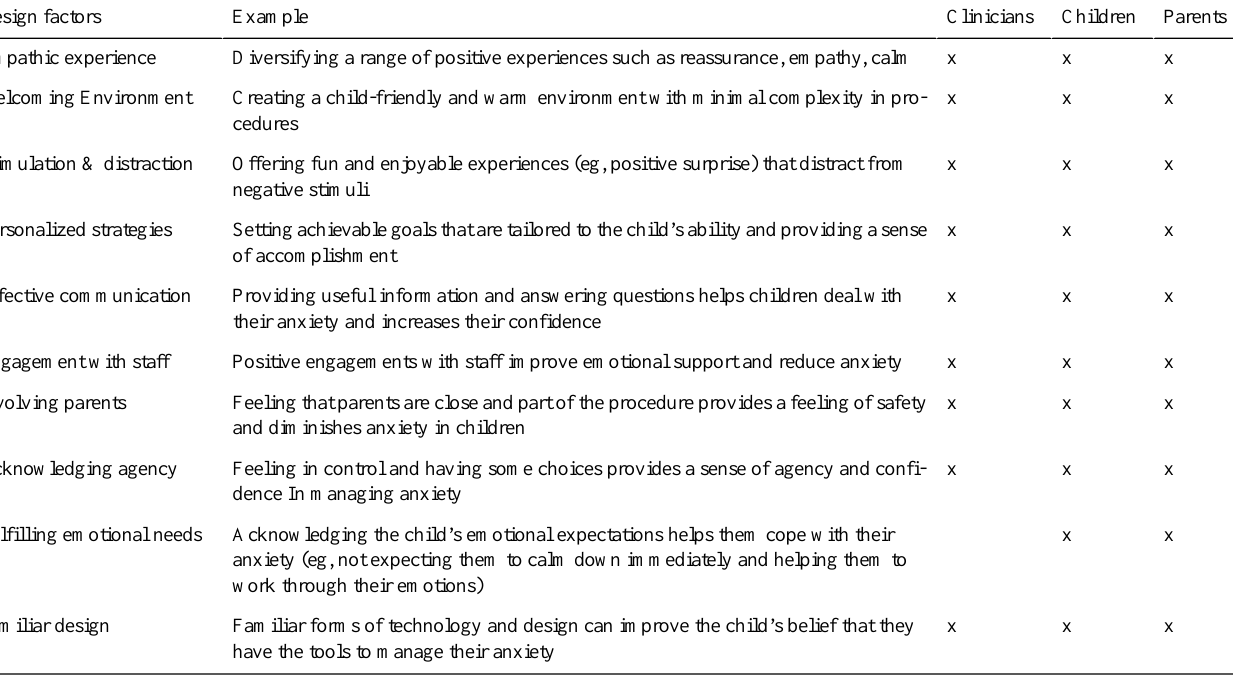
Table 4. A list of 10 design factors that can be used as input when devising a solution to assist children with managing their periprocedural anxiety. Groups of participants (clinicians, children, and parents) who have mentioned each factor are identified with an